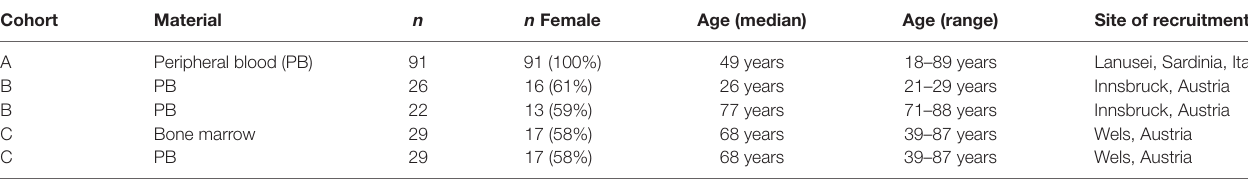
Table 1 | Demographic data on the cohorts